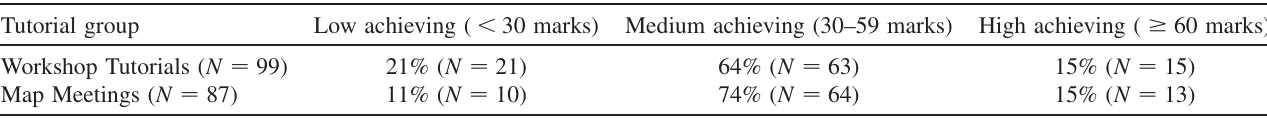
TABLE II. Percentage of persistent students receiving low, medium, and high marks, respectively, in the final examination. Tutorial